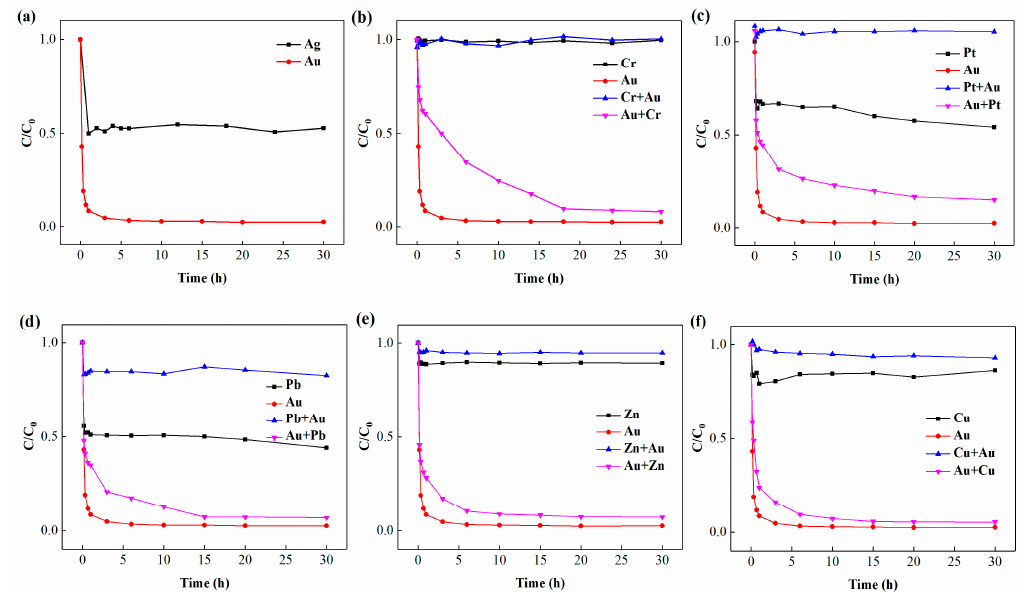
Figure 4. Au(III) recovery influenced by coexisting metal ions. ( a ) using gold and silver acting alone with bacteria. ( b–f ) using gold and other metal acting together with the bacteria. The initial concentration of each ion is 200 mg / L, and the bacterial dosage is 1 g dry weight per liter. “Au + other metal” represent Au concentration while “other metal + Au” is the concentration of other metal in the mixed solution.